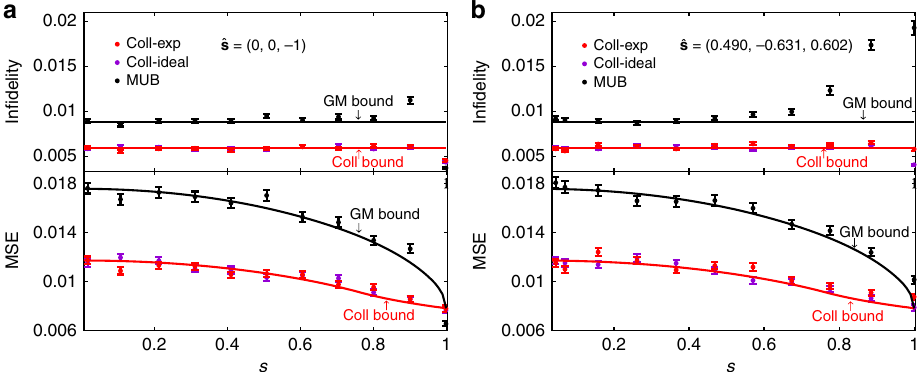
Fig. 6 Performance of the collective SIC-POVM in the tomography of mixed qubit states. Two families of mixed states with Bloch vector direcitions speci fi ed in a and b are considered. The fi gures of merit are chosen as the mean in fi delity and MSE. Also shown for comparison are the performance of MUB (simulation) as well as the Gill-Massar (GM) bound 13,44,47 and a collective (coll) bound 13,14 (see the Methods section). Here ^ s and s denote the direction and length of the Bloch vector; the sample size is N = 256; each data point is the average of 1000 repetitions, and the error bar denotes the standard